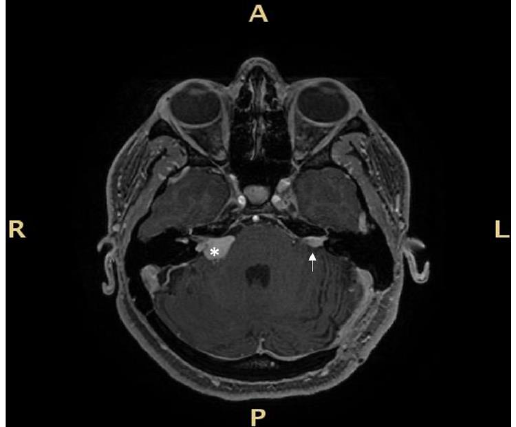
Figure 2. Magnetic resonance Imaging (MRI) before right cochlear implantation: right irradiated and stable tumour with intralabyrinthine component (white asterisk), and left side intrameatal recurrence (white arrow) after surgery via a retrosigmoid approach. R: right, L: left, A: anterior, P: posterior In 2009, the patient underwent stereotactic radiotherapy for right eight cranial nerve schwannoma. In 2014, the patient underwent successful hearing preservation surgery via retrosigmoid approach for a left eight cranial nerve schwannoma. Hearing was preserved in the right ear for the first six years, but after 2017, it progressively diminished, ending in deafness in 2019. While right hearing was diminishing, a tumour recurrence occurred in the left side (Figure 2). Post-radiation right ear anacusis occurred, despite tumour sta- bility, and an homolateral intracochlear mass was evidenced, while left hearing was pro- gressively compromised due to the recurrence, as shown in Figure 3. Before treating the left only-hearing ear recurrence (where residual and not serviceable hearing was present) in 2020, she was offered the possibility of intracochlear tumour removal and cochlear im- plant (CI) placement.